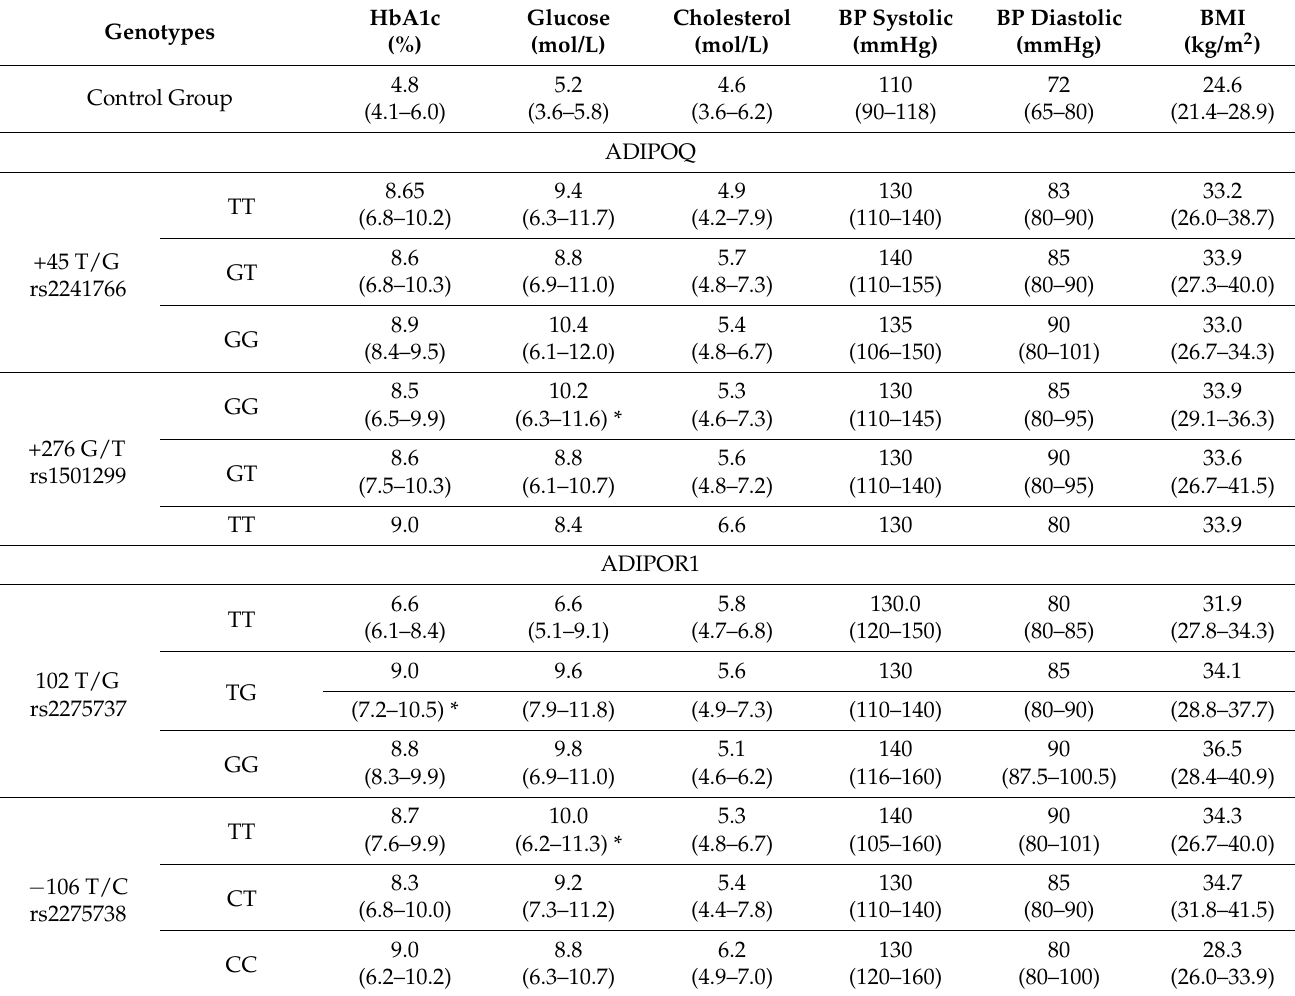
Table 3. The components of MS in patients with DM2 with respect to the adiponectin genes and their receptor polymorphism